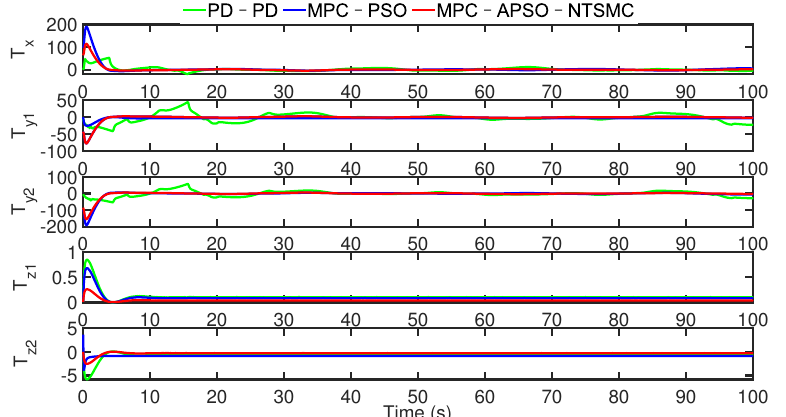
Figure 31. The thrust of thrusters for the tracking task with wave and current disturbance for Case 2.